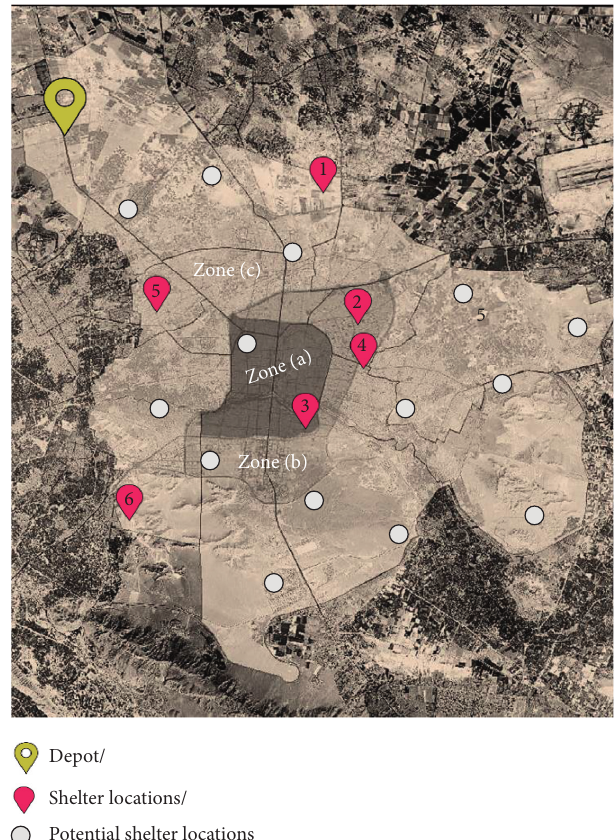
Figure 12: Traffic zones with various traffic patterns and representation of the logistics network (Google Maps).